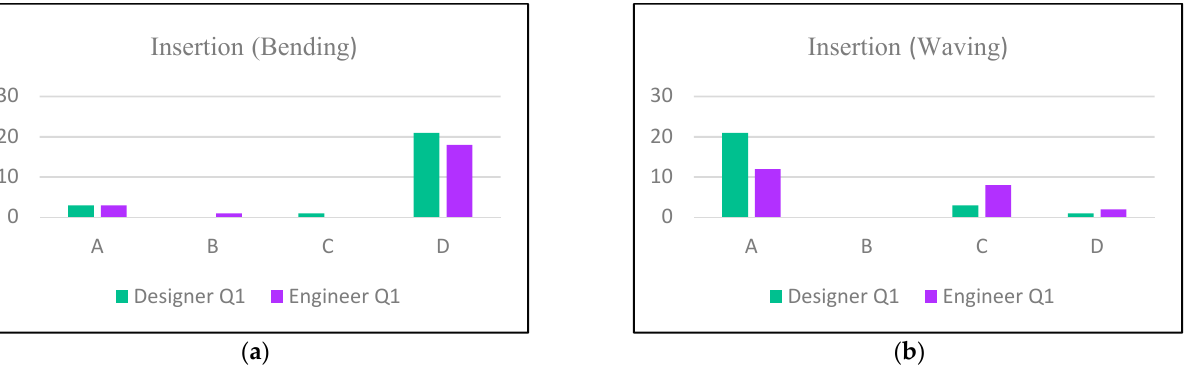
Figure 7. ( a ). Results from (Insertion task- Question1—Bending) ( b ). Results from (Insertion task-